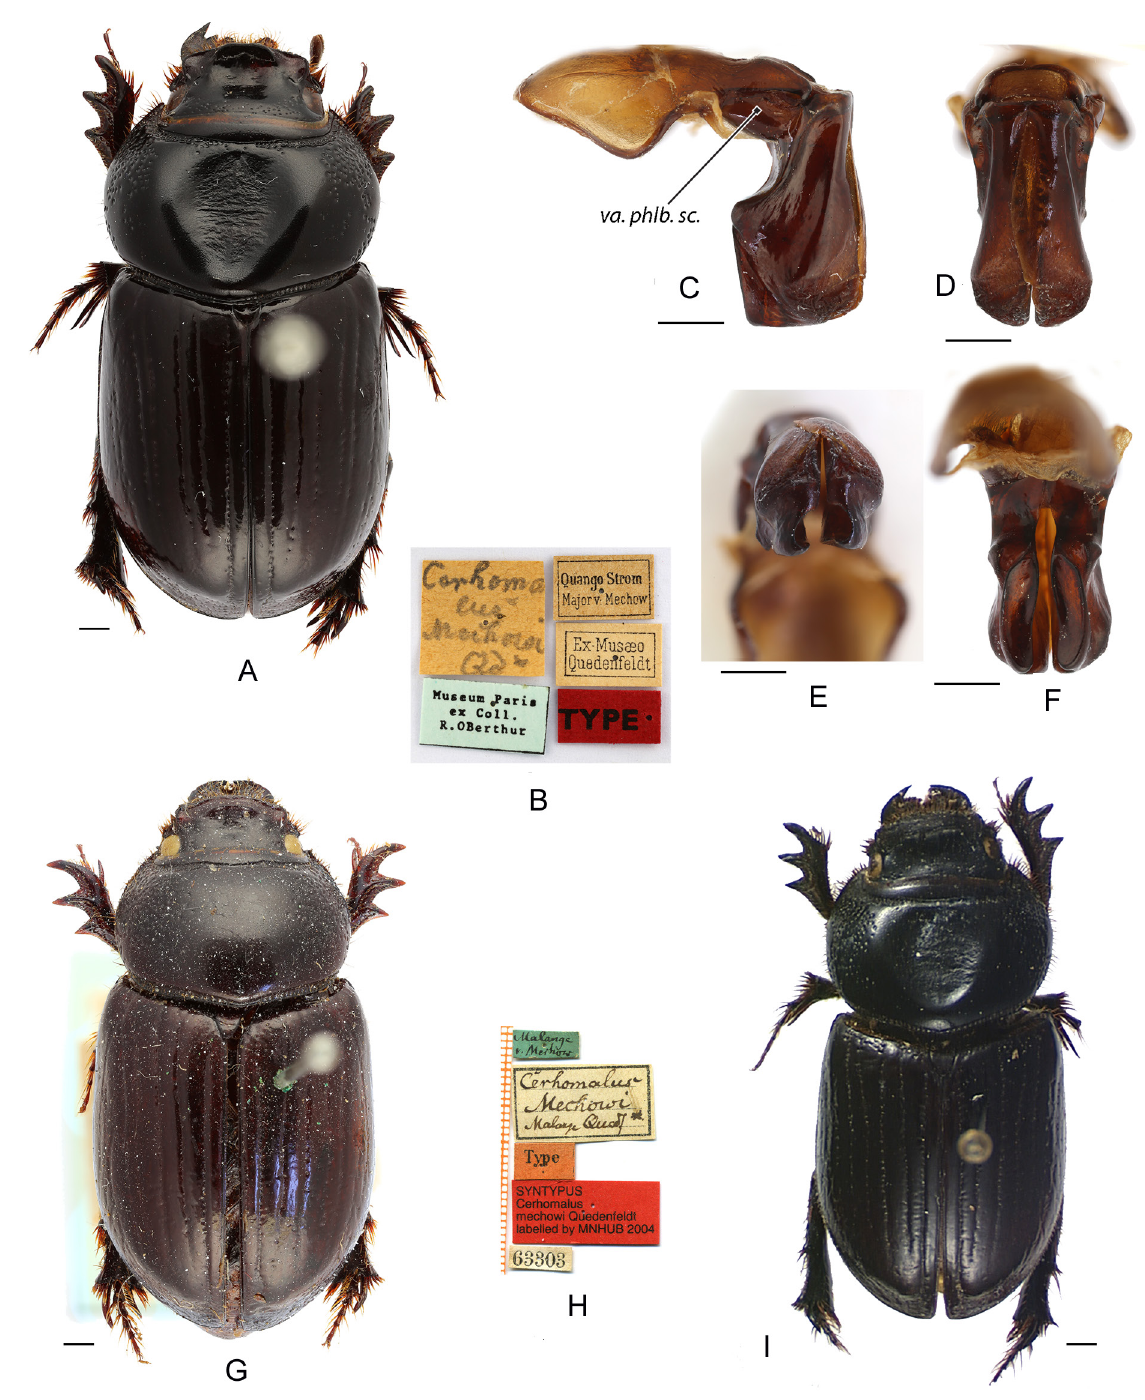
Fig. 1. Cerhomalus mechowi Quedenfeldt, 1884. A–F . Lectotype, ♂ (MNHN). G . Paralectotype, ♀ (MNHN). H–I . Paralectotype, ♂ (ZMHUB). A, G, I . Habitus in dorsal view. B, H . Labels. C . Aedeagus in lateral view. D . Parameres in dorsal view. E . Parameres in apical view. F . Parameres in ventral view. Abbreviation: va. phlb. sc. = ventroapical phallobase sclerite. Scale bars = 1.0